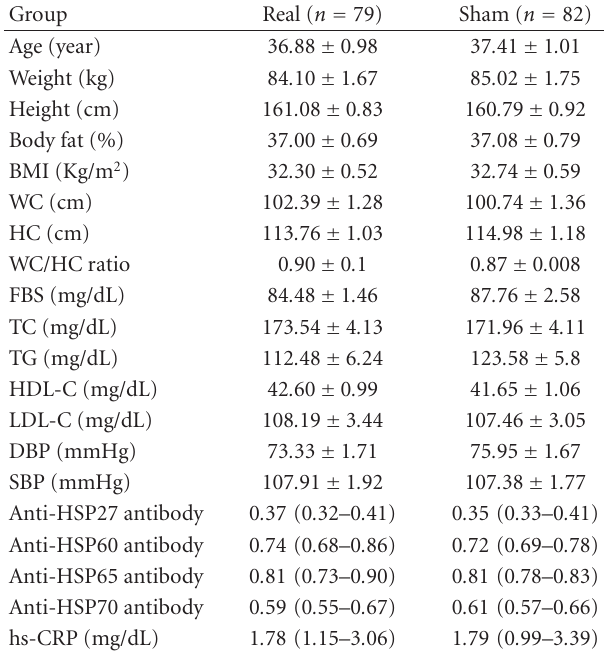
Table 1: Comparison between clinical and biochemical character- istics of